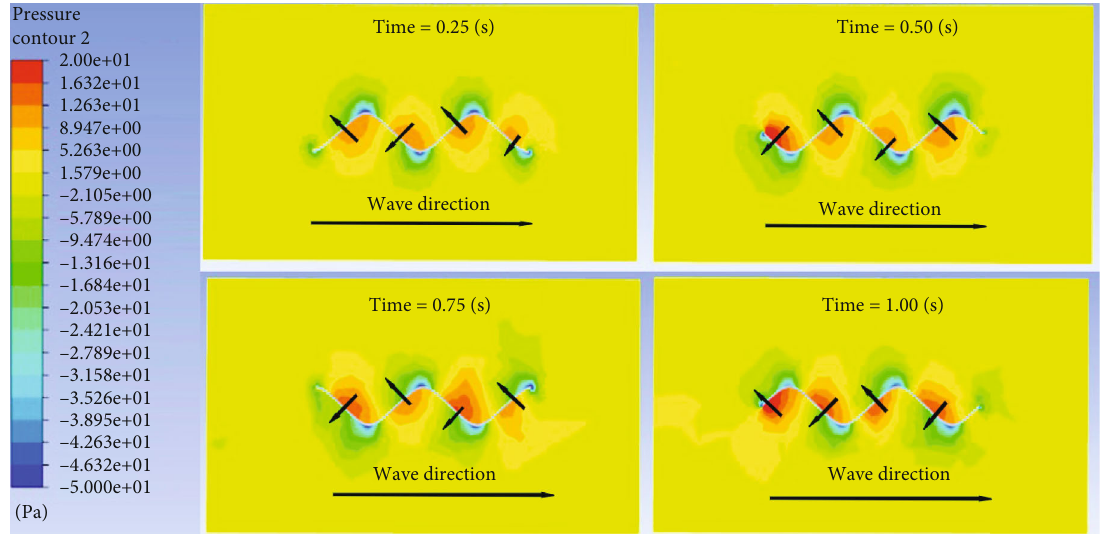
Figure 7: Pressure distribution diagram of cross-sectional fl ow fi